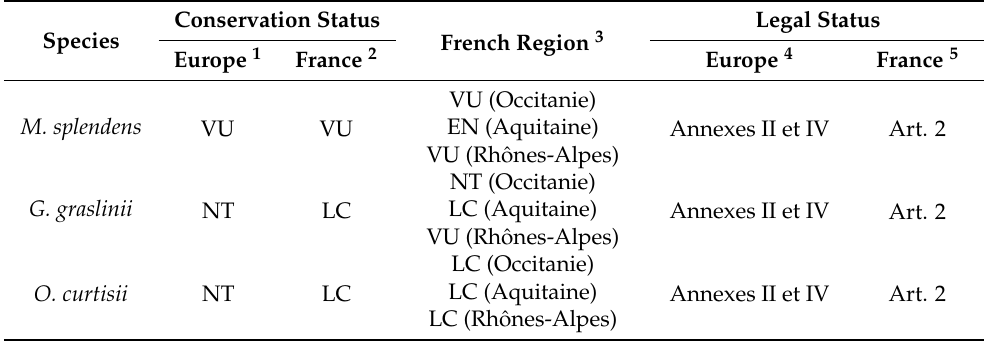
Table 1. The Splendid Cruiser Macromia splendens , Pronged Clubtail Gomphus graslinii, and Orange- spotted Emerald Oxygastra curtisii conservation status and legal status.